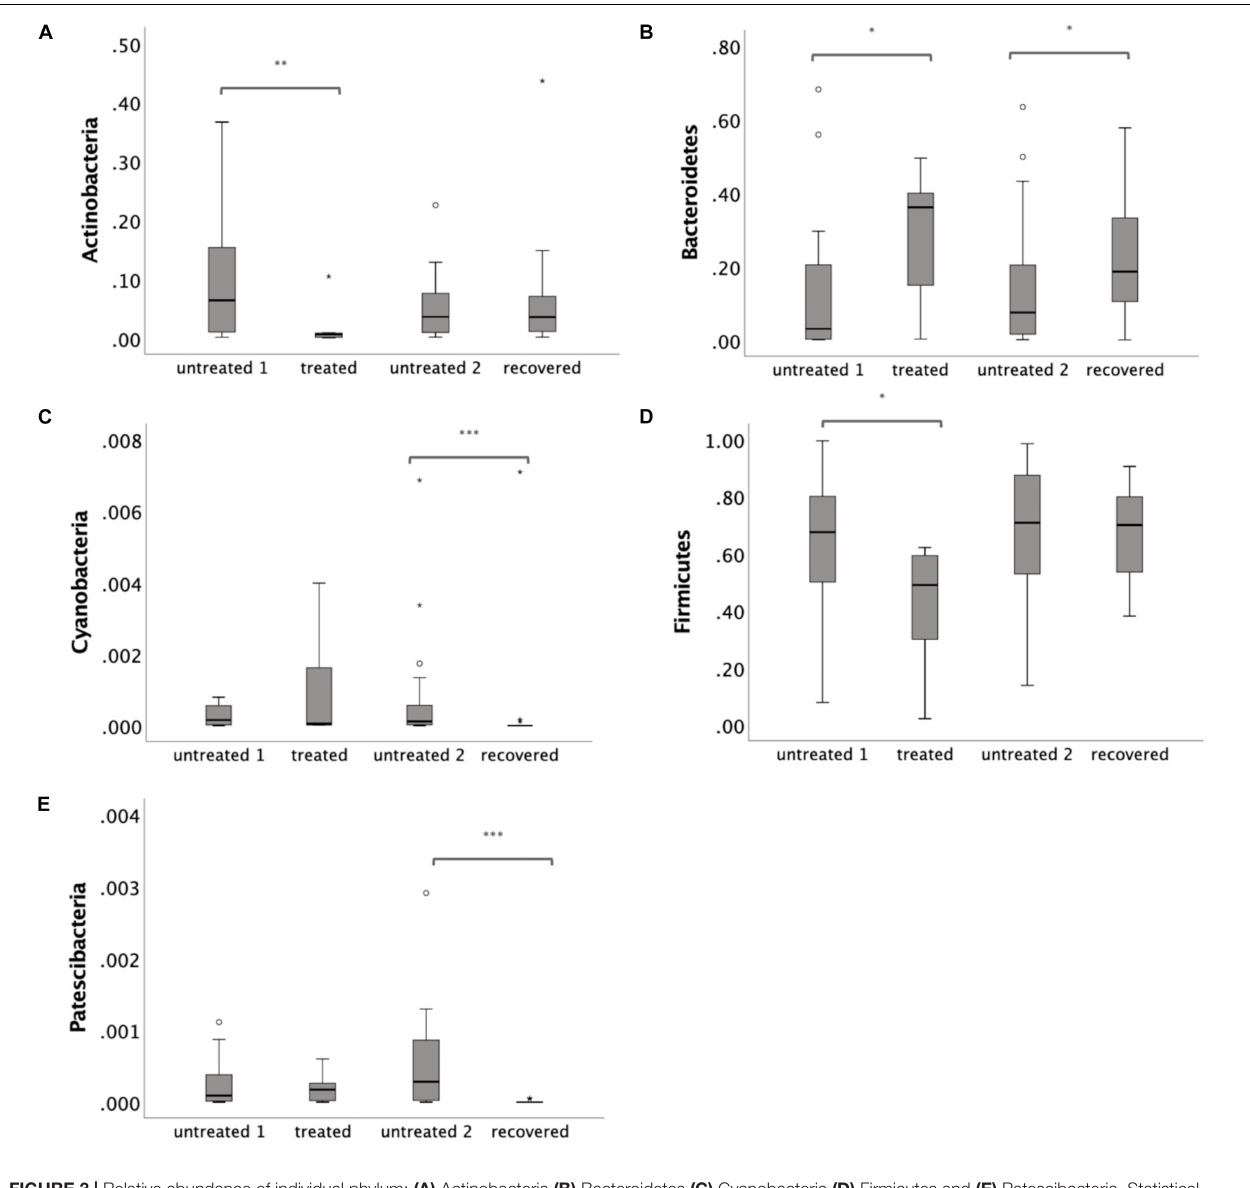
FIGURE 3 | Relative abundance of individual phylum: (A) Actinobacteria (B) Bacteroidetes (C) Cyanobacteria (D) Firmicutes and (E) Patescibacteria. Statistical significance was calculated between the multi-drug-resistant tuberculosis (MDR-TB) treated group and untreated group 1, and between the MDR-TB recovered group and untreated group 2 (Mann–Whitney U test). * p < 0.05, ** p < 0.01, *** p <